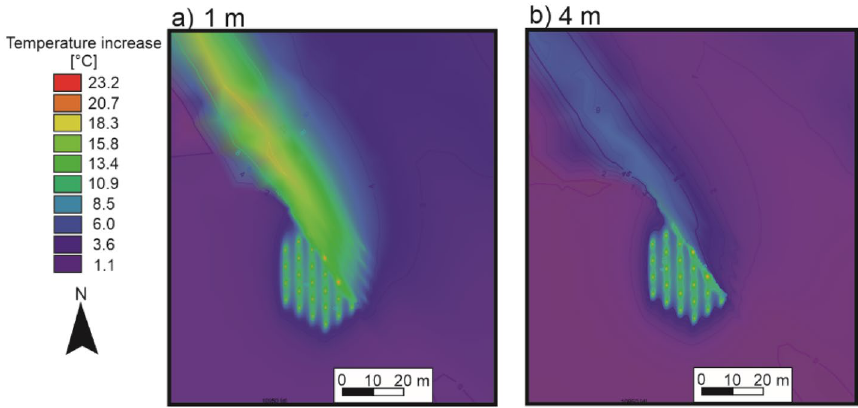
Fig. 14 Heat plumes after a simulation time of 20 years for a constant hydraulic conductivity of 10 3 m s 1 and varying thicknesses of a 1 m and b 4